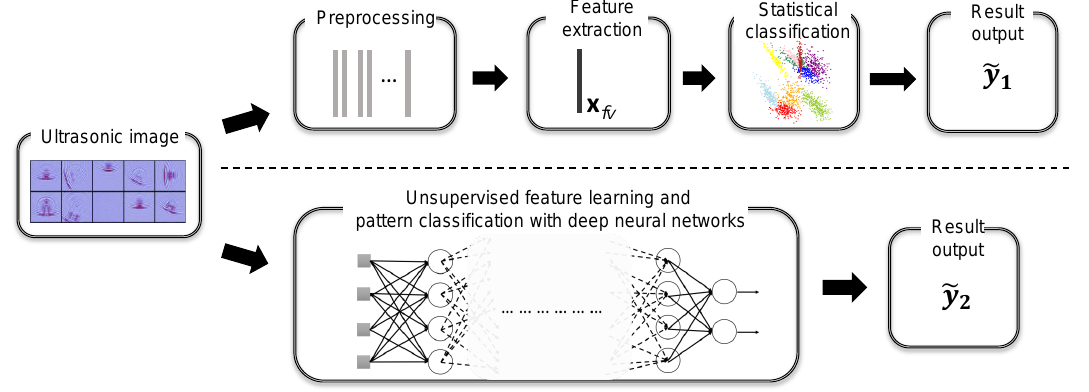
Figure 2. The general designs of computer vision